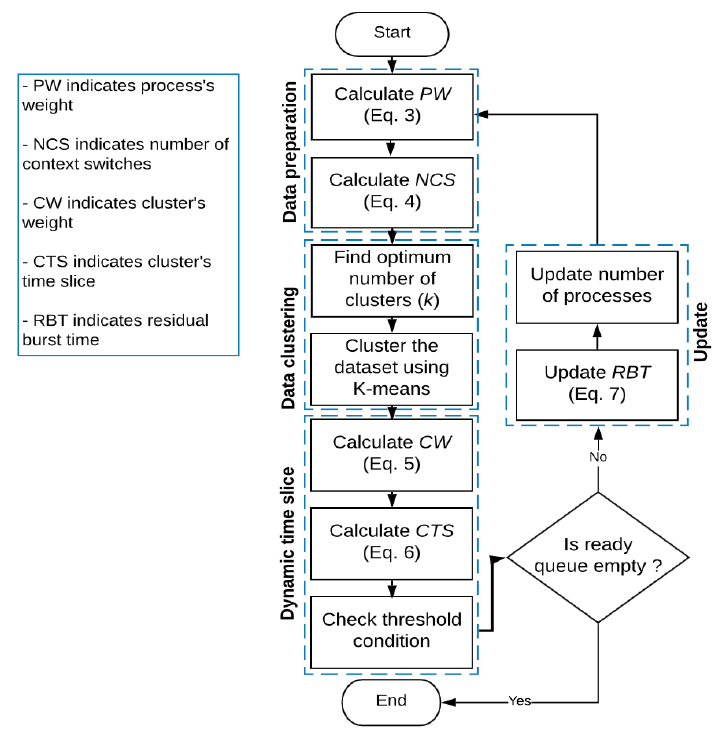
Figure 2. Algorithm flowchart.